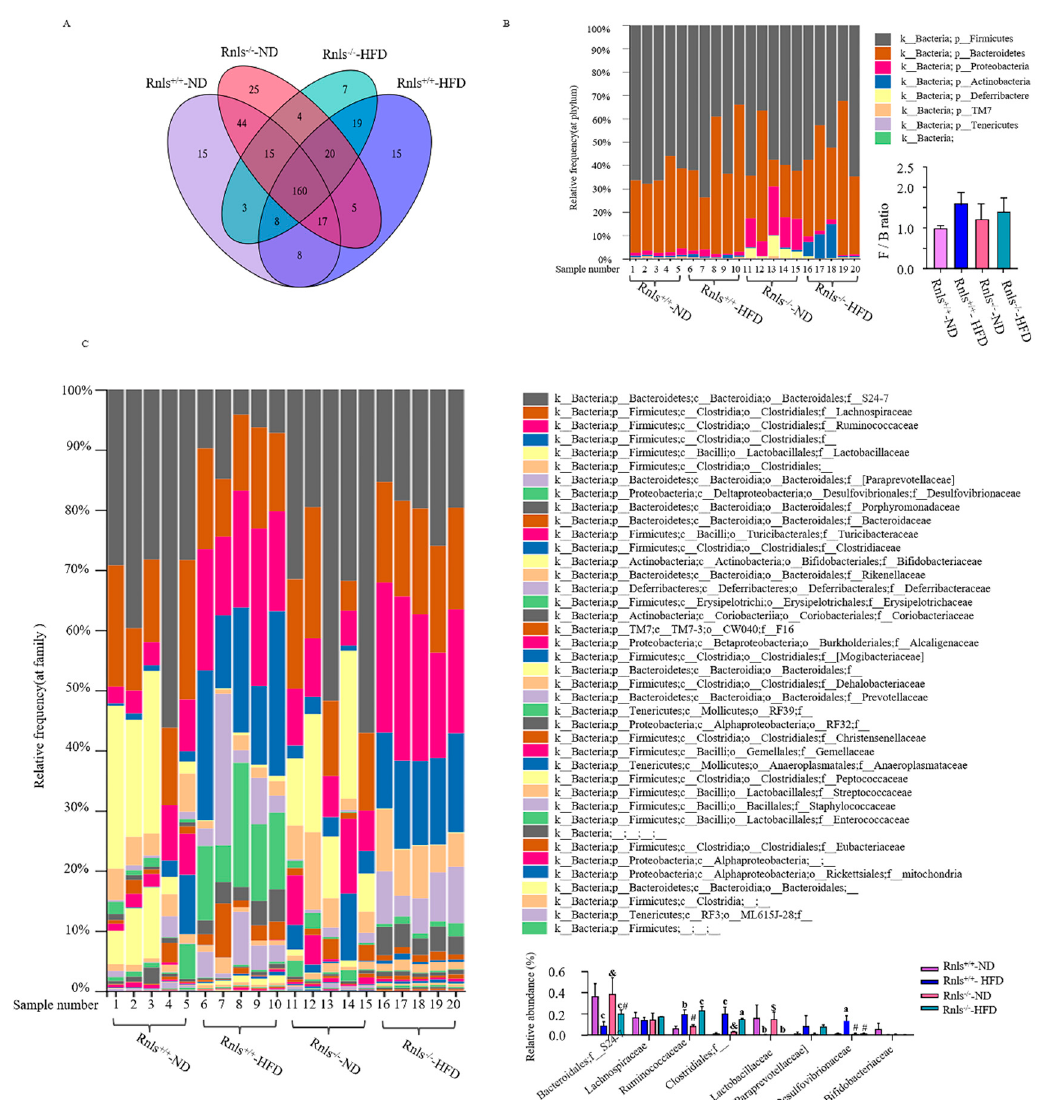
Figure 5. Relative microbial phylum and family abundances based on 16S ribosomal RNA gene sequencing. ( A ) Venn diagram showing OTUs among diverse groups. The 160 ‘core’ OTUs are shown. The mice of the Rnls +/+ -ND, Rnls − / − -ND, Rnls +/+ -HFD, and Rnls − / − -HFD groups presented 270, 290, 252, and 236 OTUs, respectively. The inside numbers represent the common OTUs among two or more samples and specific families. ( B ) Relative phylum abundances across Rnls +/+ and Rnls –/– mice fed with HFD or ND. ( C ) Relative family abundances among Rnls –/– and Rnls +/+ mice fed normal diet or high-fat diet. Data are predicted through two-way ANOVA (Tukey’s post hoc test) with repeated measures. a: p < 0.05, b: p < 0.01, c: p < 0.001 indicating significant differences among diverse mouse groups compared with the Rnls +/+ -ND group. #: p < 0.05, $: p < 0.01, &: p < 0.001 indicating a significant difference compared with the Rnls +/+ -HFD group. Rnls –/– -ND, renalase gene knockout mice fed with normal diet; Rnls +/+ -ND, wild-type mice fed with normal diet; Rnls –/– -HFD, renalase gene knockout mice fed with high-fat diet; Rnls +/+ -HFD, wild-type mice fed with high-fat diet; F, Firmicutes; B, Bacteroidetes; OTU, operational taxonomic unit.